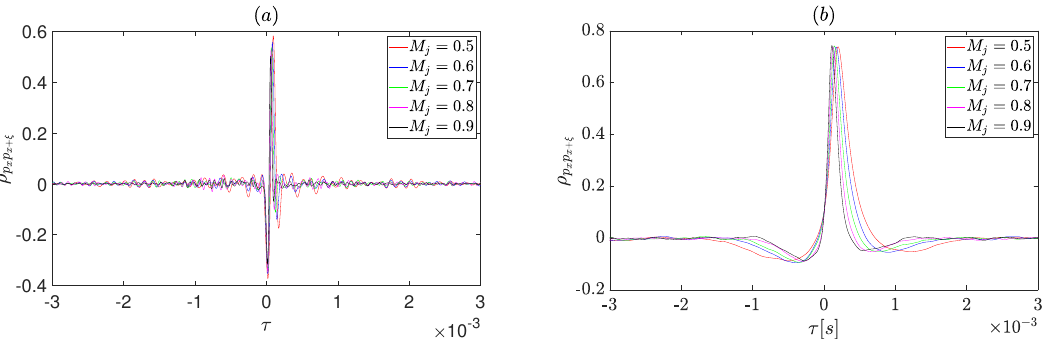
Figure 6. Mach effect on the wall pressure cross-correlation coefficient for the jet–plate distance H/D = 0.75: ( a ) x/D = 5; ( b ) x/D =